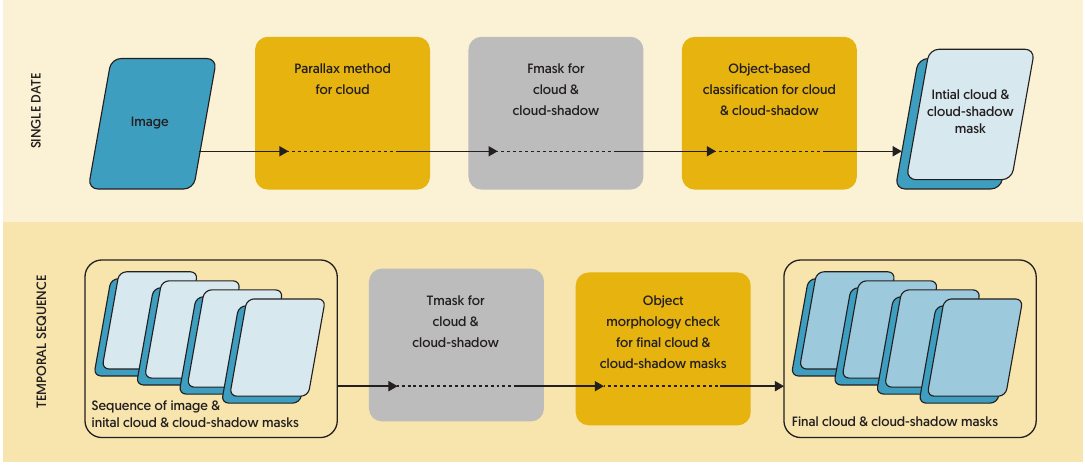
Figure 1. Conceptual diagram of cloud and cloud-shadow classification. The algorithm improves the initial cloud and cloud-shadow mask through the parallax method and object-based classification, and improves the final cloud and cloud-shadow masks with an object-based morphology check. Novel additions to current algorithms are highlighted in yellow